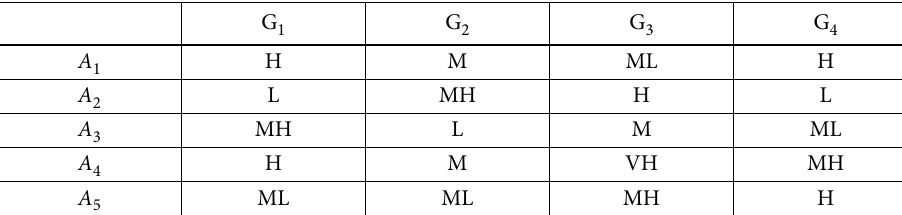
Table 4. Linguistic assessing matrix by third expert